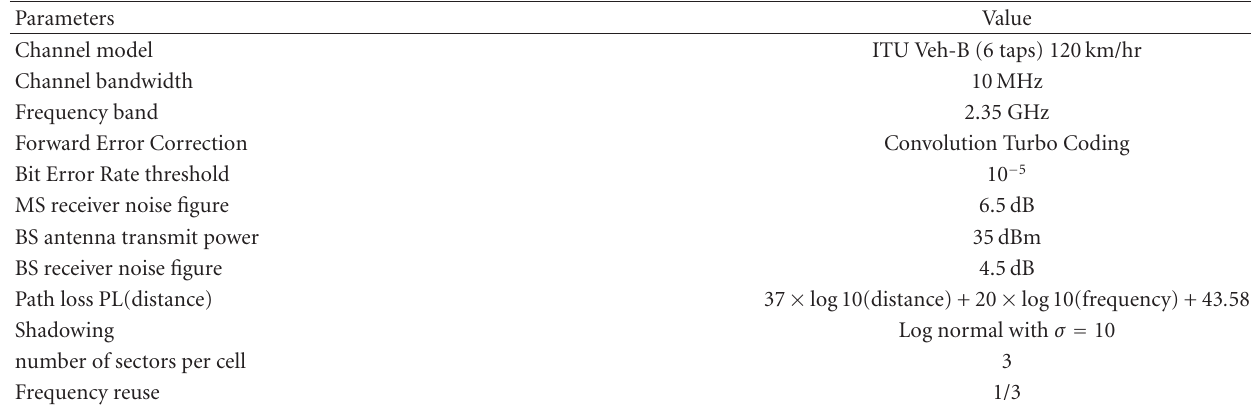
Table 12: Simulation parameters [16].